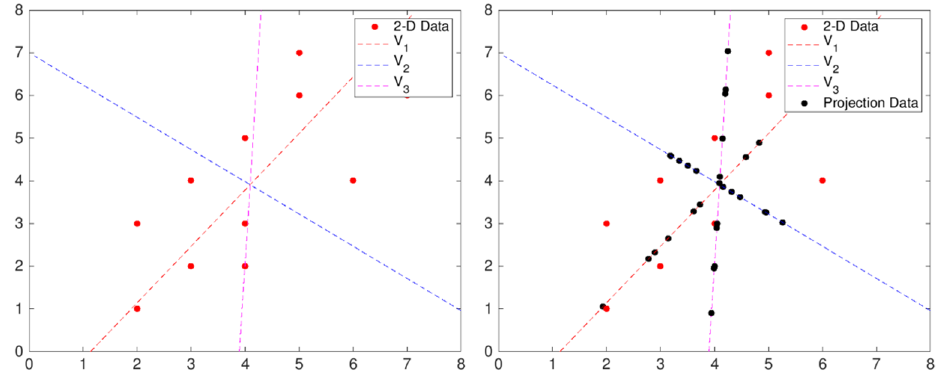
Figure 8. Scatter diagram and result of data projection on principal component vector.